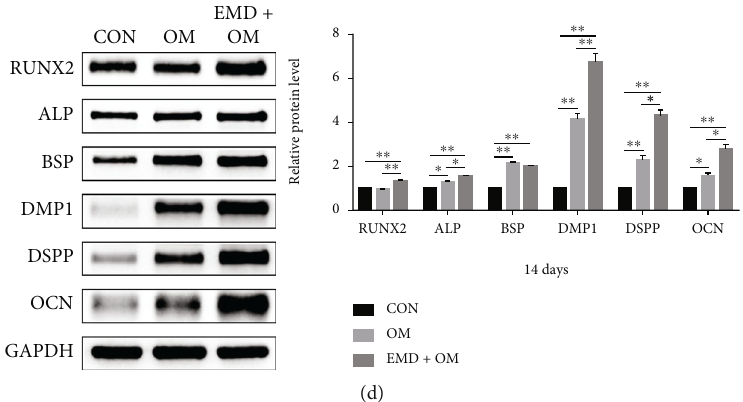
Figure 3: The in fl uence of EMD on odontoblastic di ff erentiation of DPSCs in vitro . (a) The expression levels of odonto/osteogenic-related marker genes (RUNX2, ALP, BSP, DSPP, DMP1, and OCN) were detected by real-time RT-PCR at days 3, 7, and 14. (b) – (d) Relative protein expression levels of odonto/osteogenic-related markers were detected by western blot analysis at days 3, 7, and 14. The results were quanti fi ed using Image Lab ™ software. All data are displayed as means ± SD by three individual tests ( n =3). ∗ P < 0 : 05 , ∗∗ P < 0 : 01